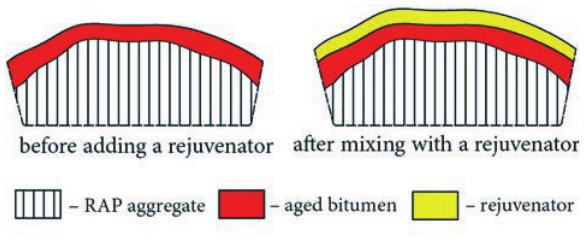
Fig. 2. Structure of a bitumen film coating a mineral particle of the reclaimed asphalt pavement mixture